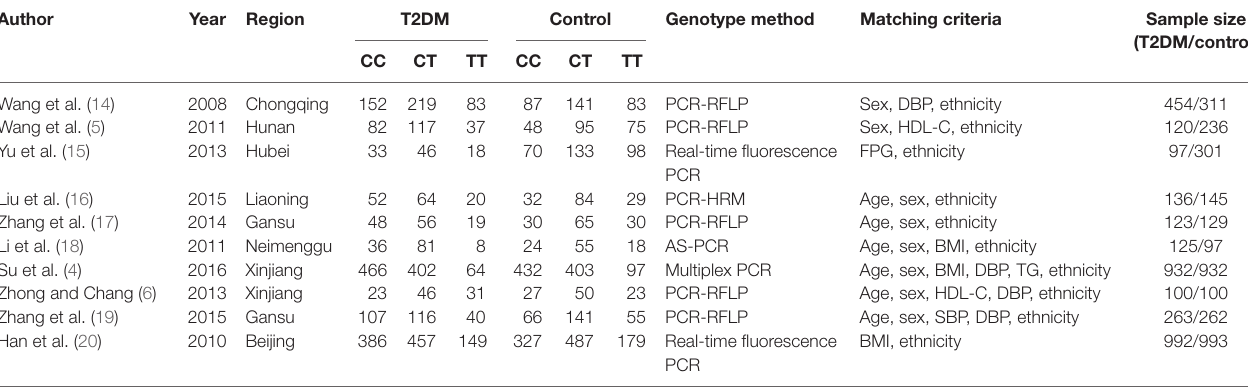
taBLe 1 | Characteristics of the investigated studies of the association between SLC30A8 gene 807C/T (rs13266634 C/T) polymorphism and T2DM in the Chinese population.